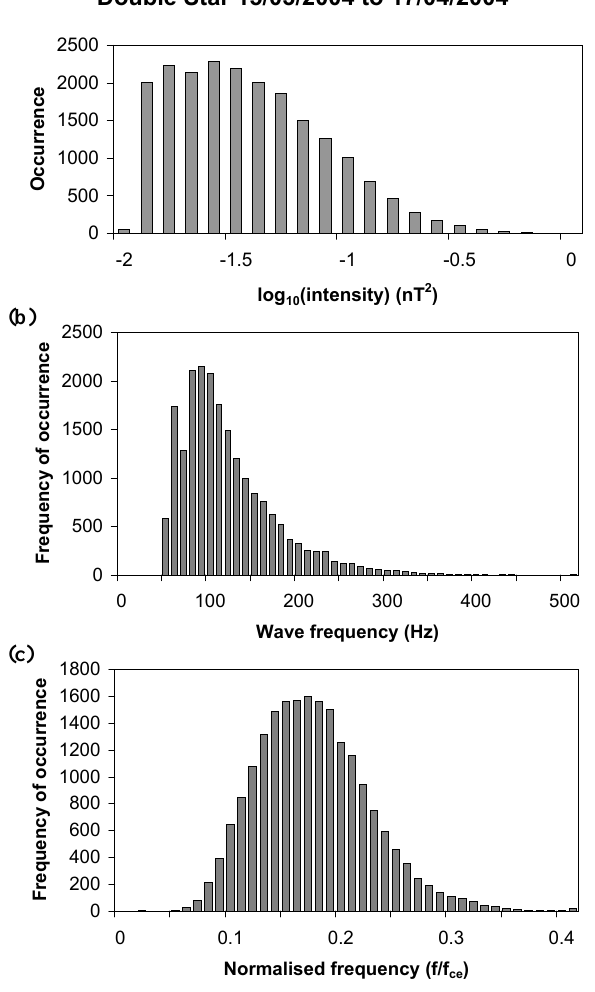
Fig. 1. Histograms of the logarithm of the lion roar intensity (a) , average frequency (b) , and normalised frequency f / f ce (c)